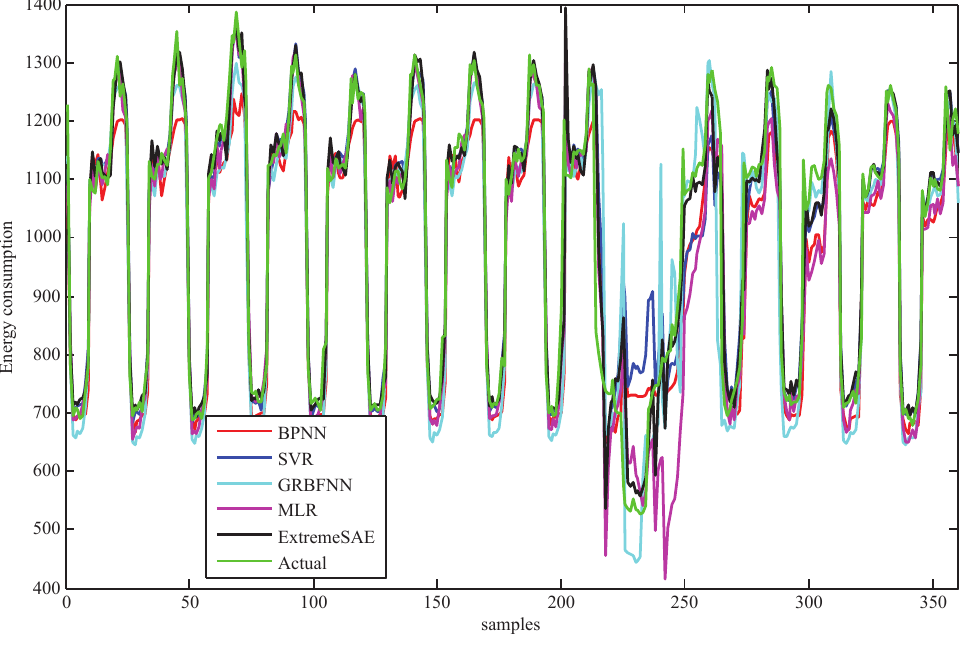
Figure 11. Prediction results of the five models in the 60 min experiment.